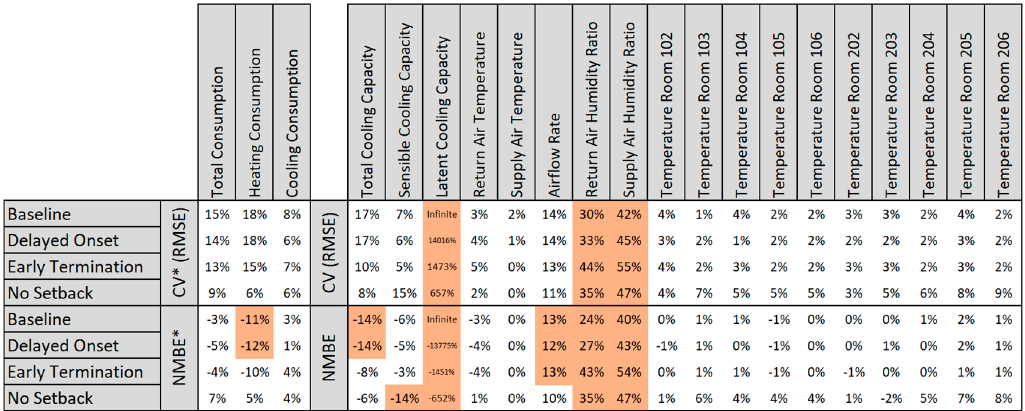
( d ) Figure 6. Total building electricity consumptions of baseline and faulted scenarios: HVAC setback error (winter). ( a ) baseline; ( b ) delayed onset; ( c ) early termination; ( d ) no setback. Figure 7 shows the same time series plots, but for the summer season experiments and simulations. The magnitudes of energy consumption are slightly reduced compared to winter results. Based on model predictions shown in Figures 6 and 7, the building model reasonably captures the seasonal difference between heating and cooling